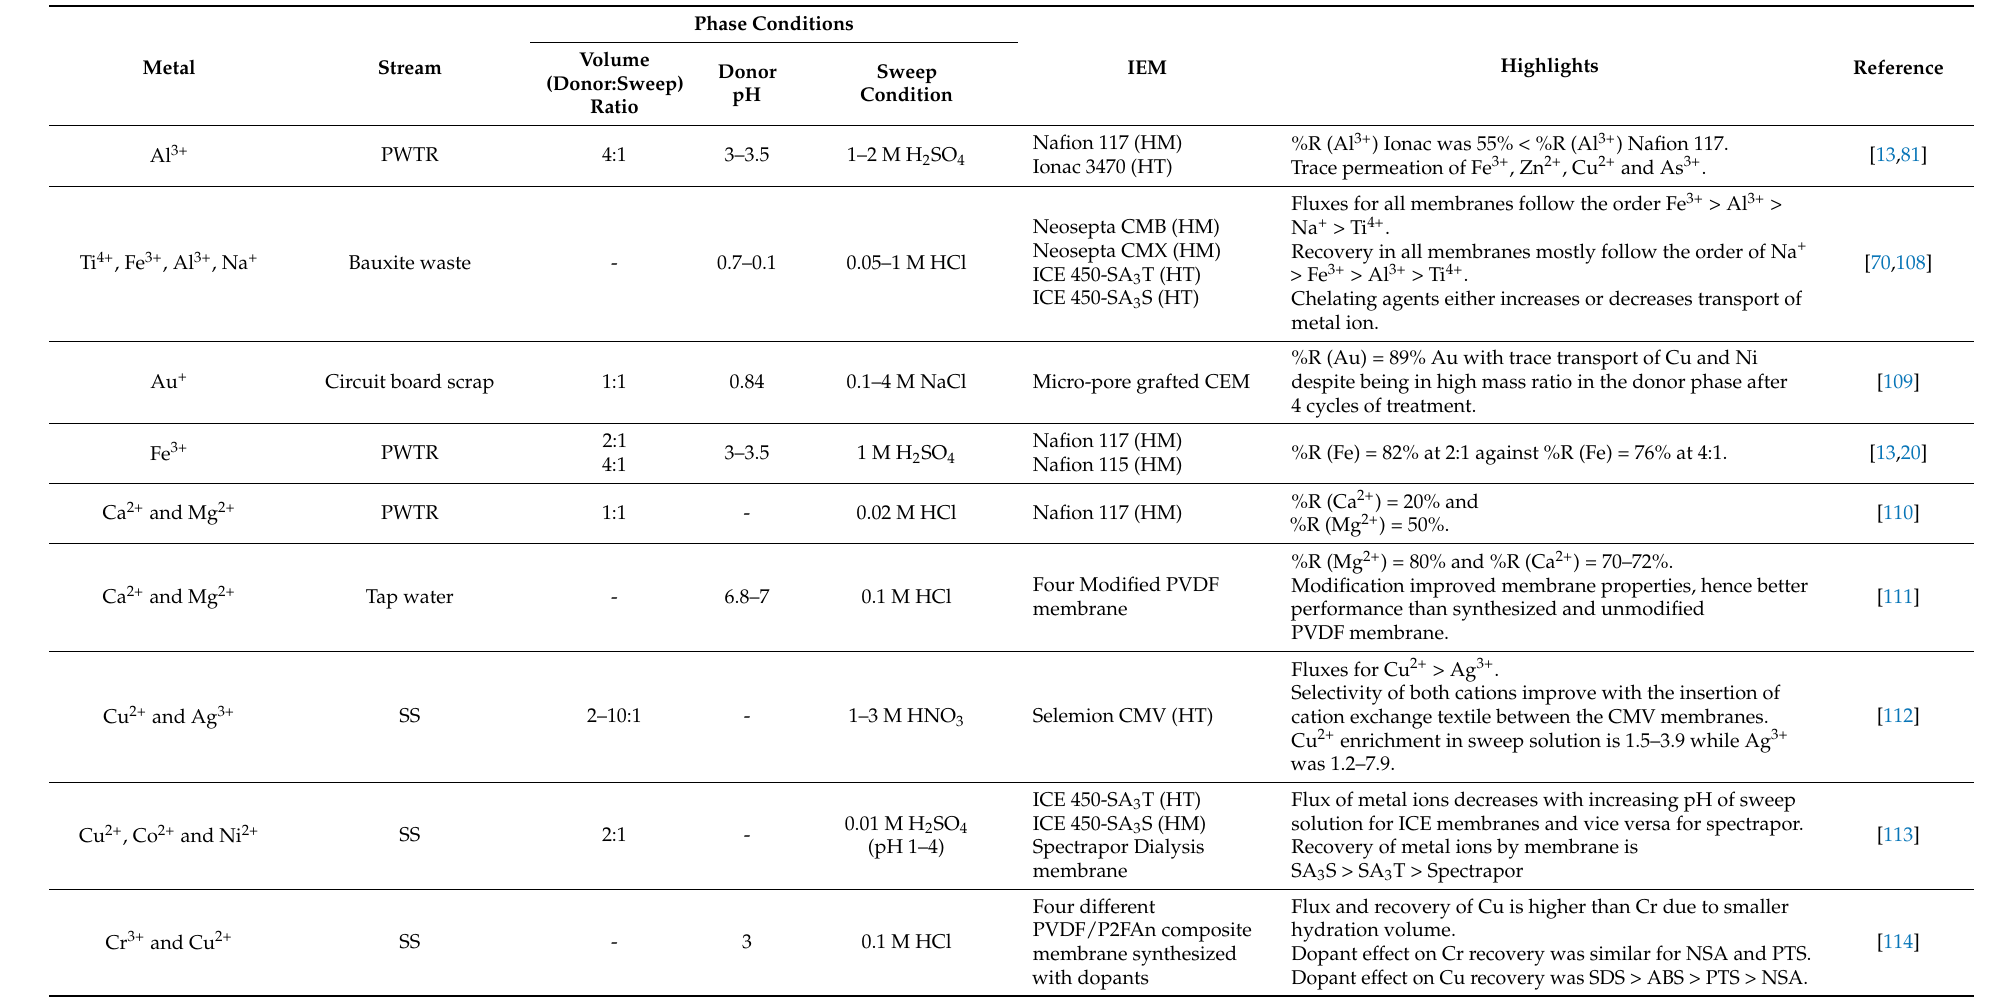
Table 3. Target metal ion recovery using DMP